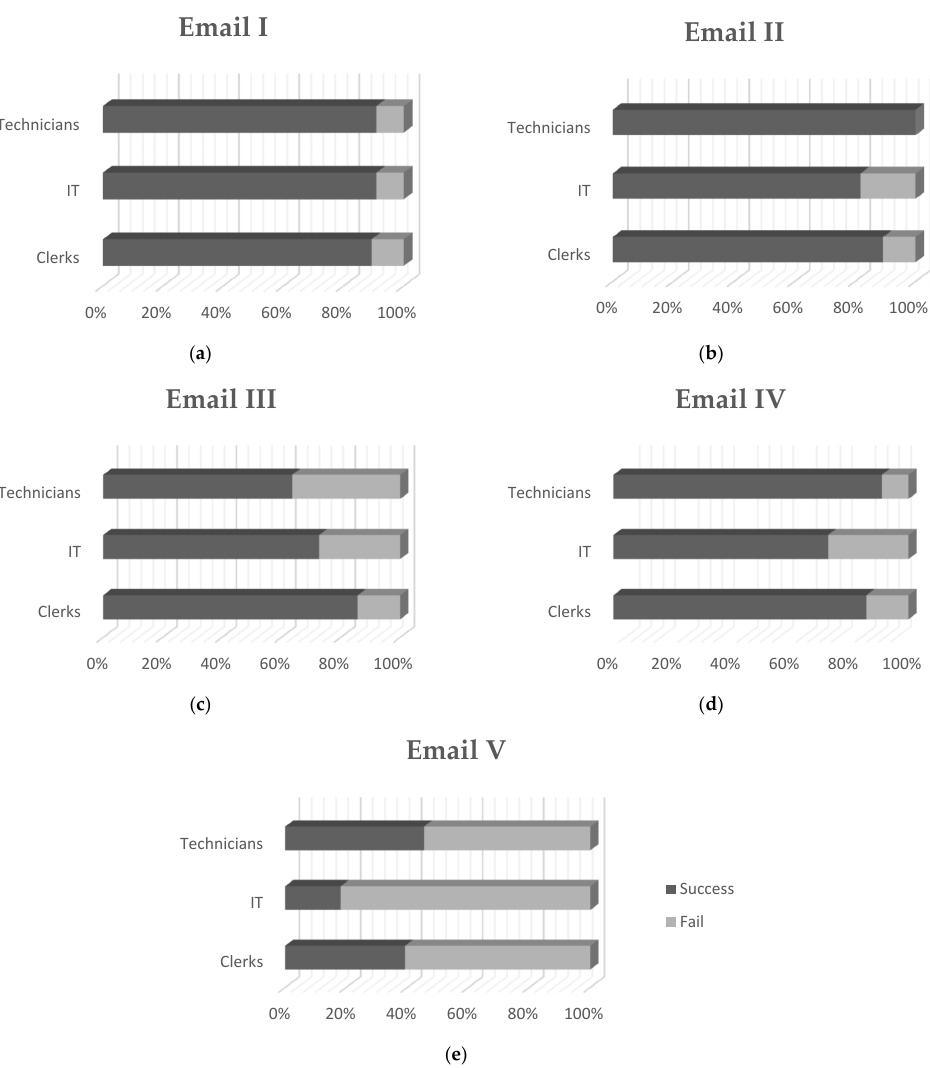
Figure 6. Campaign assessment results per expertise for: ( a ) email I, ( b ) email II, ( c ) email III, ( d ) email IV and ( e ) email V, of the phishing quiz.